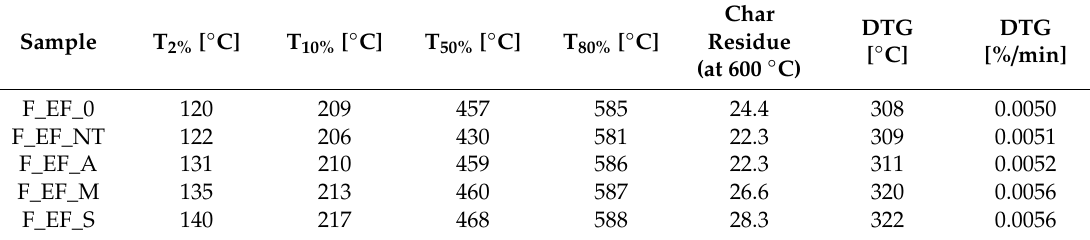
Table 6. Characteristic parameters describing the flammability of polyurethane foams.